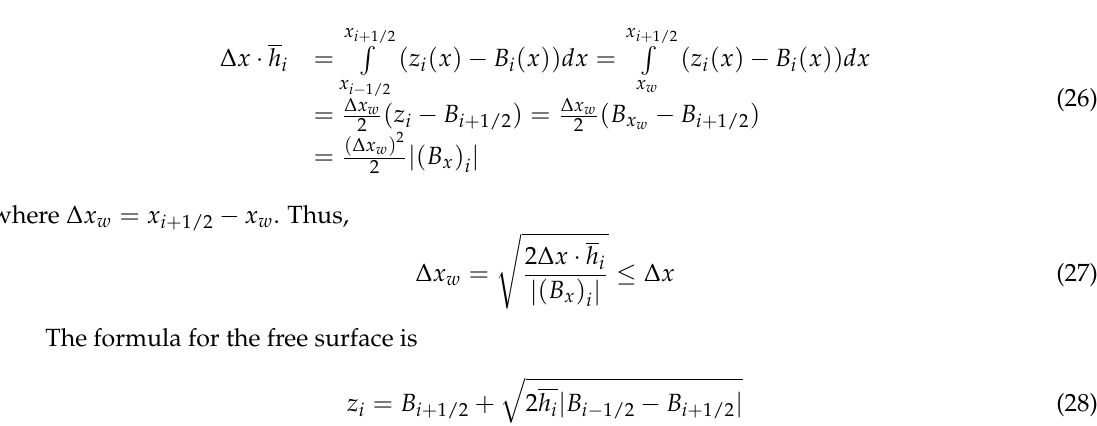
Figure 2. Partially flooded cell.